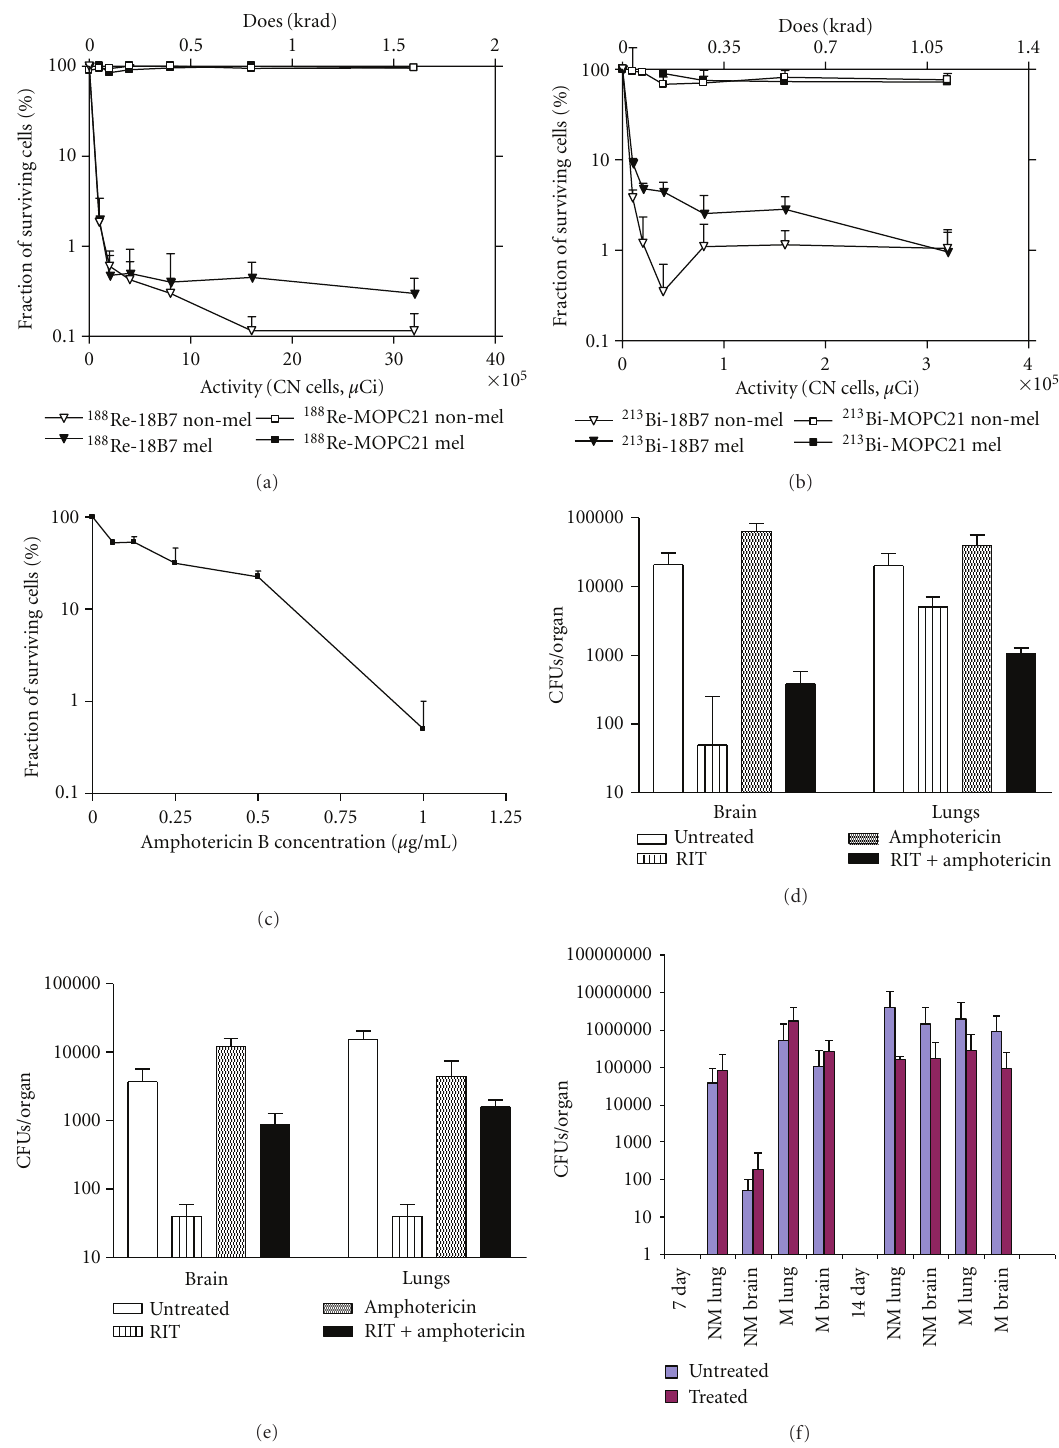
Figure 5: Comparison of RIT and amphotericin e ffi cacy towards nonmelanized and melanized CN in vitro and in vivo. (a–c) In vitro killing and dosimetry of melanized and nonmelanized CN cells treated with: (a) 188 Re-labeled 8B7 and control isotype-matching MOPC21 mAbs; (b) 213 Bi-labeled 18B7 and control MOPC21 mAbs; (c) amphotericin B; mel:melanized CN cells; non-mel:nonmelanized CN cells; (d,e) CFUs in the lungs and brains of mice infected with nonmelanized or melanized CN. AJ/Cr mice were infected IV with 3 × 10 5 CN cells and 24hr later either given 100 μ Ci 213 Bi-18B7 RIT or amphotericin B at 1 μ g/g body weight on Days 1, 2, and 3 after infection or combined treatment or left untreated: (d) nonmelanized CN; (e) melanized CN. Detection limit of the method was 50 CFUs. No CFUs were found in the brains and lungs of mice infected with melanized CN cells and treated with RIT which are presented in the graph as 40 CFUs/organ; (f) CFUs in the brain and lungs of mice infected with 3 × 10 5 melanized (M) or nonmelanized (NM) CN cells and treated with amphotericin B at 1 μ g/g body weight for 14 days. Mice were sacrificed at days 7 and 14 posttreatment; adapted from